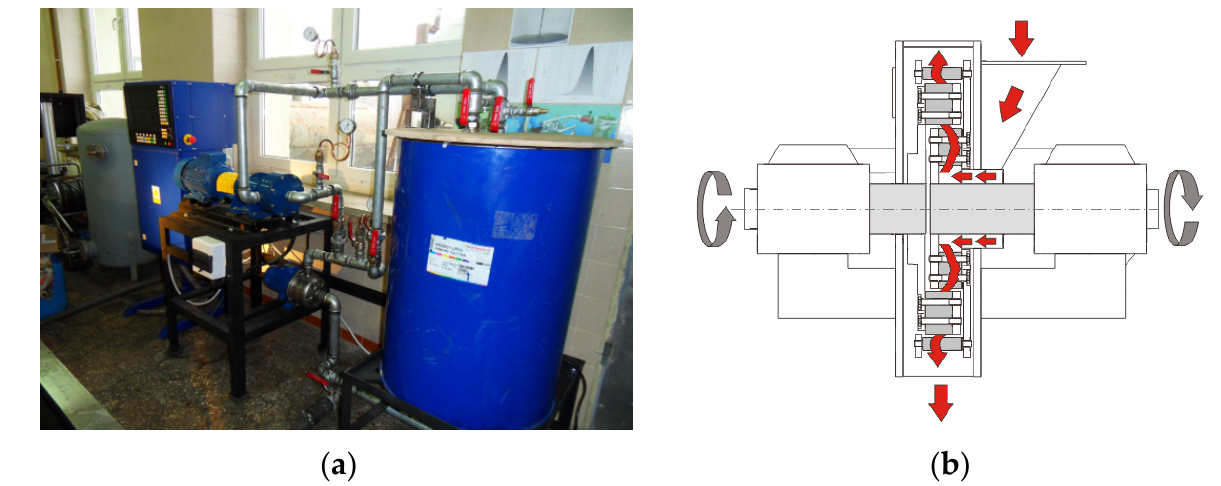
Figure 3. Roto-turbulent micronizer: ( a ) General view of micronizing installation; ( b ) Diagram of roto-turbulent micronizer.